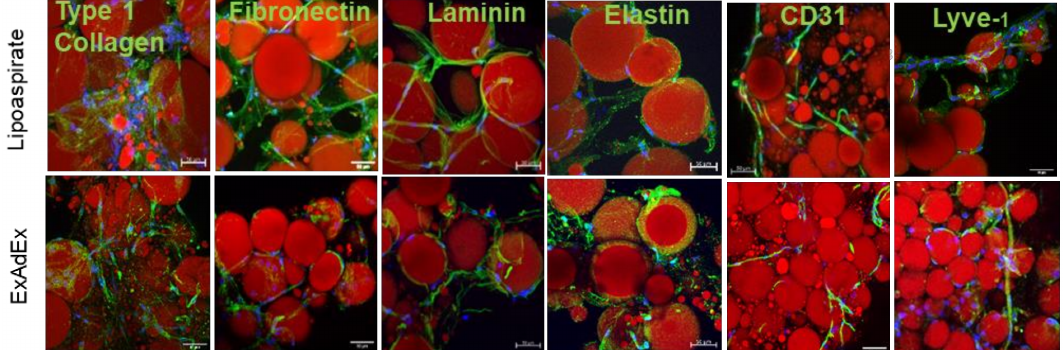
Figure 2. Maintenance of the extracellular matrix and the endothelial cell network. The lipoaspirate and the ExAdEx product were labeled for the indicated proteins of the extracellular matrix. The vessel and lymphatic endothelial cell networks were visualized with CD31 and Lyve-1 labeling, respectively. The lipoaspirate was fixed after 1 day in culture, whereas the ExAdEx product was fixed after 60 days. Scale bar: 50 µ